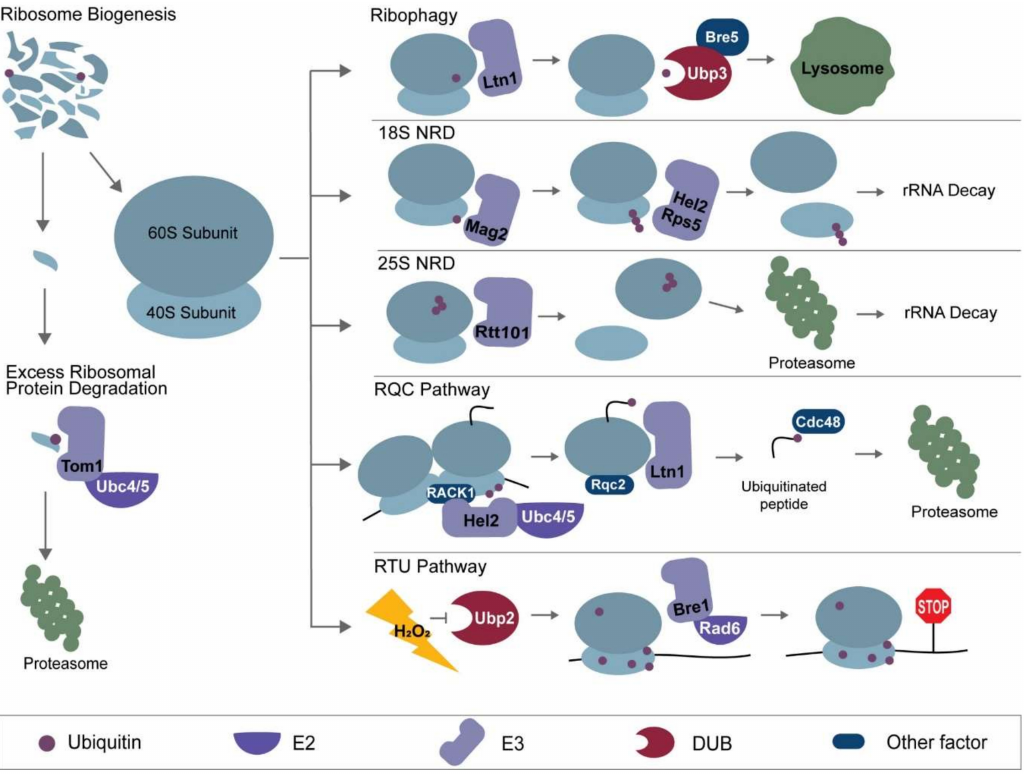
Figure2. Summaryoftheubiquitin-mediatedpathwaysoftranslationalcontrol. Theleftpanelhighlights processes of ribosome turnover (ribosome biogenesis and excess ribosomal protein degradation). The right panel highlights ribosome fates through ubiquitin-mediated mechanisms, namely ribophagy, 18S non-functional rRNA decay (NRD), 25S NRD, Ribosome-associated protein Quality Control (RQC), and Redox control of Translation by Ubiquitin (RTU). Proteins involved in each mechanism are labeled as their yeast homologs, although some of these pathways have also been explored in mammalian